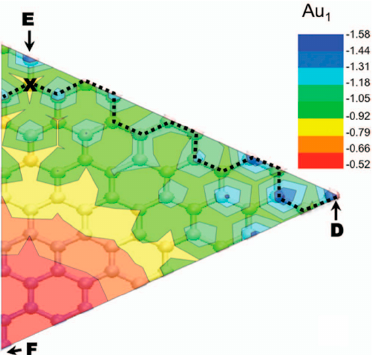
Figure 6. Potential energy surfaces for Au 1 sampled at the top and ring center sites in the symmetry-irreducible zone of the full graphene/Ru(0001) surface. The dashed line signs the adatom minimum-energy diffusion path. The minimum energy diffusion path for the adatom is marked by a dashed line. “D”, “E”, and “F” mark the preferential adsorption sites, and “X” marks the highest-energy site. Reproduced from Reference [99] with permission from the American Institute of Physics.